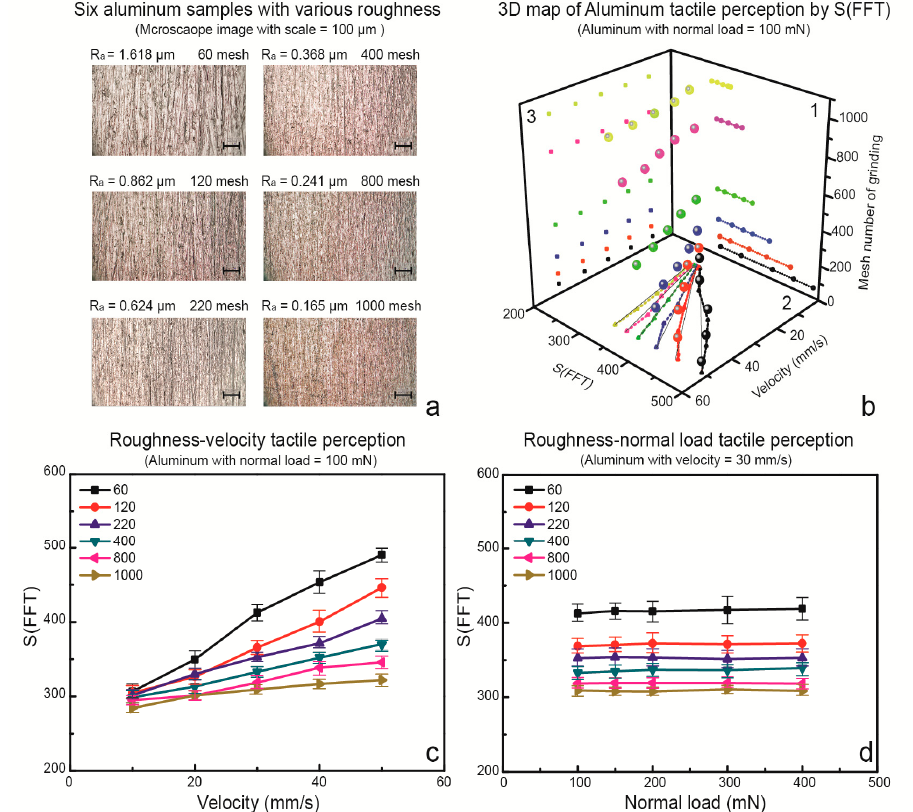
Figure 4. Aluminum roughness tactile discrimination as a function of velocity and normal load. ( a ) Microscope images of six aluminum surface topographies with various roughness; ( b ) three-dimensional (3D) map of aluminum tactile perception by S ( FFT ) with a normal load equal to 100 mN; ( c ) Roughness-velocity tactile perception as a function of velocity; ( d ) Roughness-normal load tactile perception as a function of normal load.